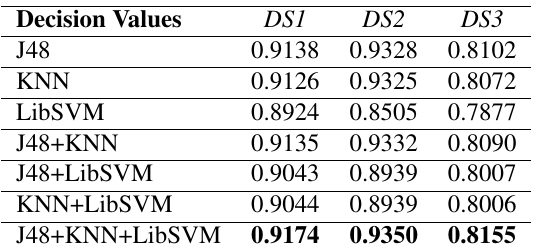
Table 8. The results of the decision values with the weight val- ues { 1/2, 1/3, 1/6 }